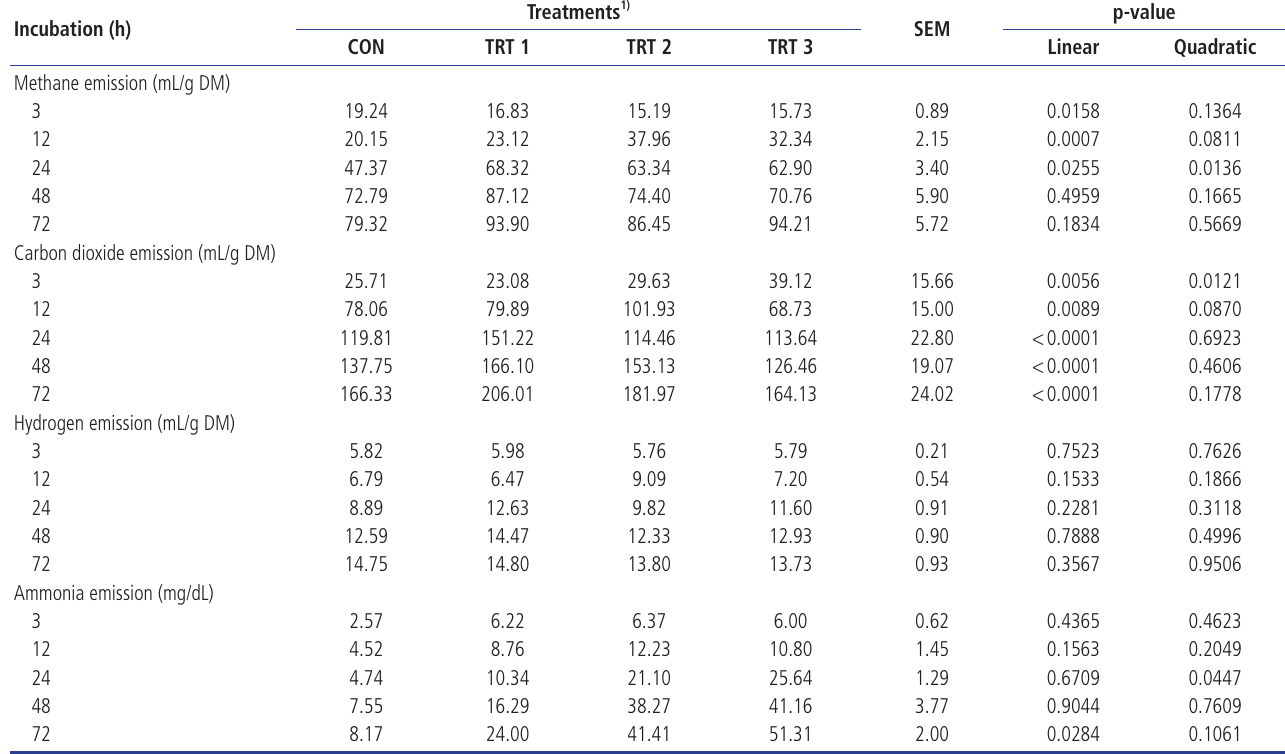
Table 4. Effect of Gelidium amansii extract on in vitro methane, carbon dioxide, hydrogen and ammonia emission by mixed rumen microbial fermentation Incubation (h)